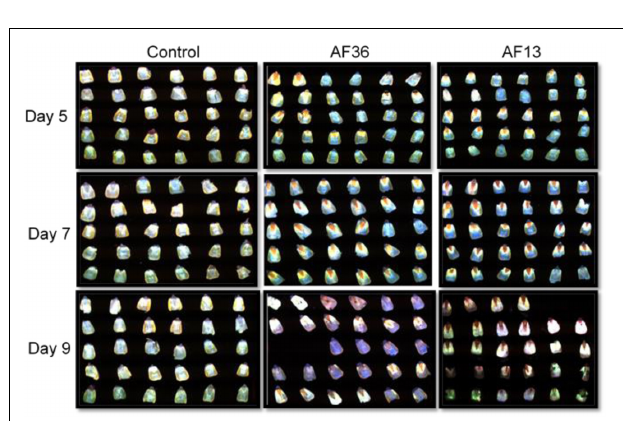
FIGURE 2 | Fluorescence images of maize kernel cross-sections inoculated with toxigenic and atoxigenic strains of Aspergillus flavus over a 9 day growth period, including controls. Due to extensive deterioration, two kernels from the two treated groups (AF13 and AF36) on day 9, were excluded from analysis.